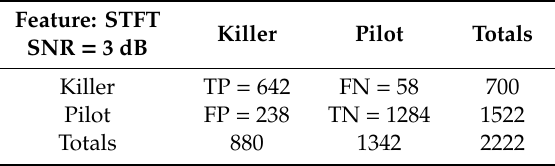
Table 6. Classification results: STFT, SNR = 3 dB.